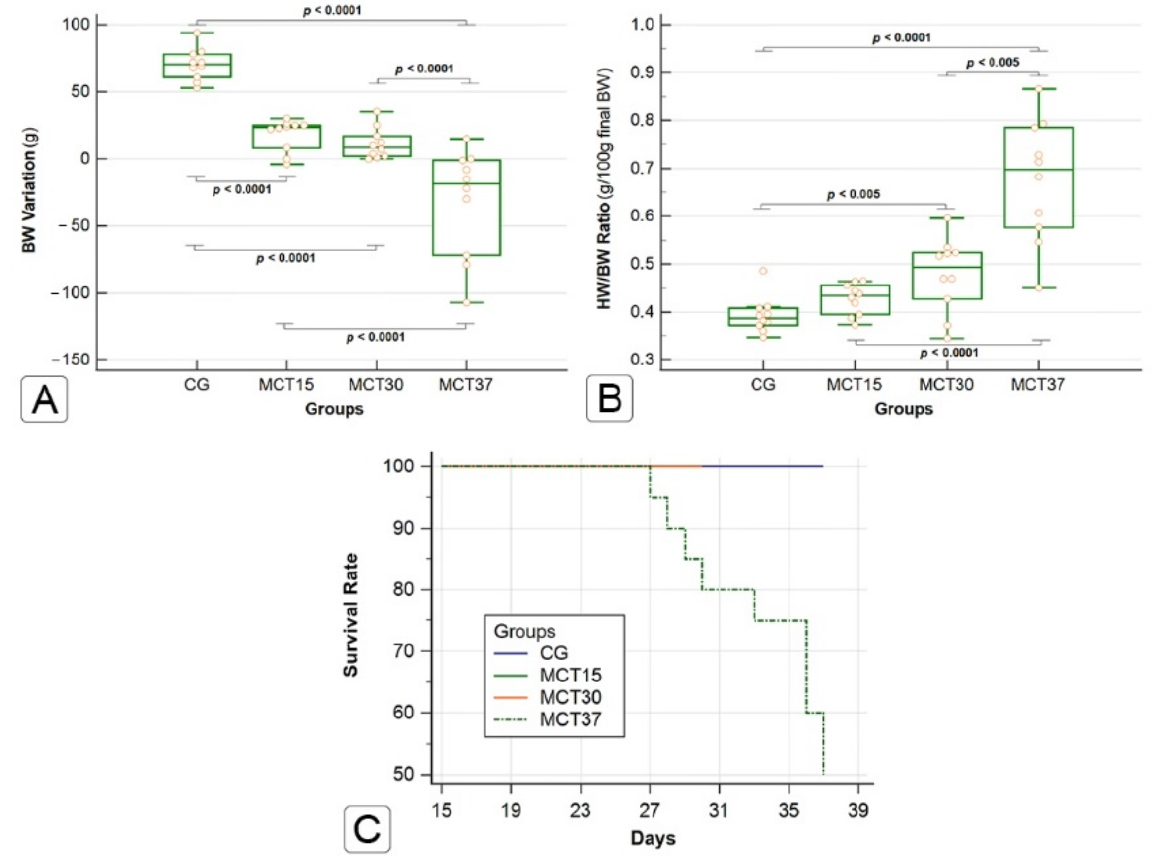
Figure 1. Body weight (BW) variation ( A ) and HW/BW ratio ( B ); g/100 g final BW, are expressed as median and interquartile range (Kruskal–Wallis method followed by Simes–Hochberg method). Mortality was observed daily, and the figure shows the survival rate at each time of the different experimental groups, through a Kaplan–Meier curve ( C ).